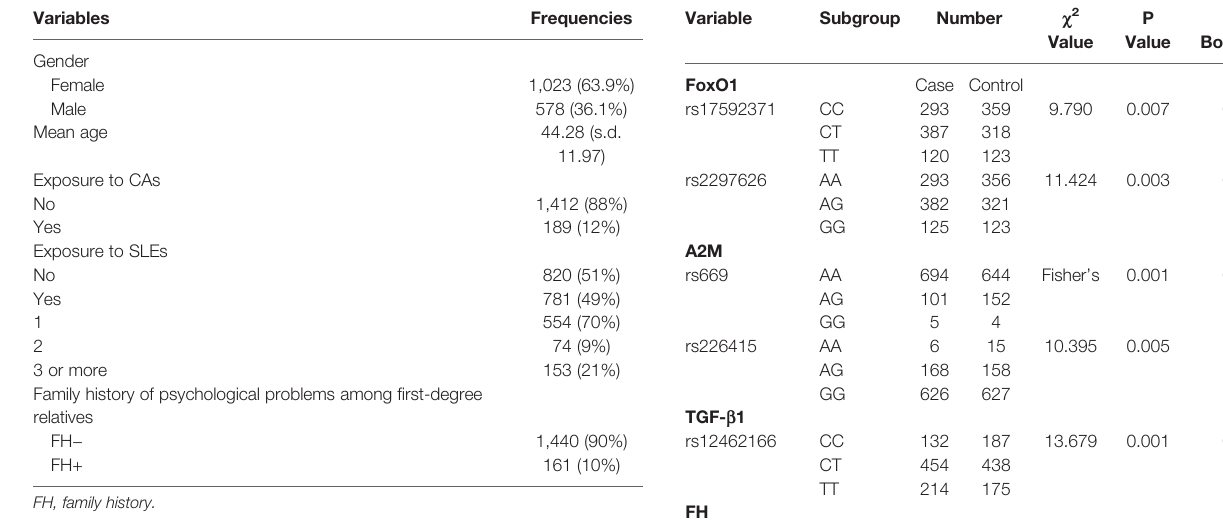
TABLE 2 | Association of Study Variables with